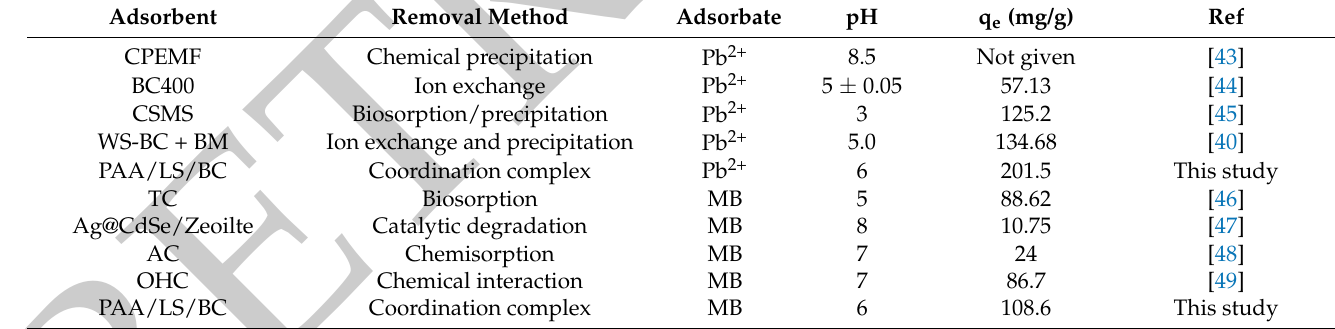
Table 3. A comparison of the method for removing Pb 2+ and MB with other reported methods.